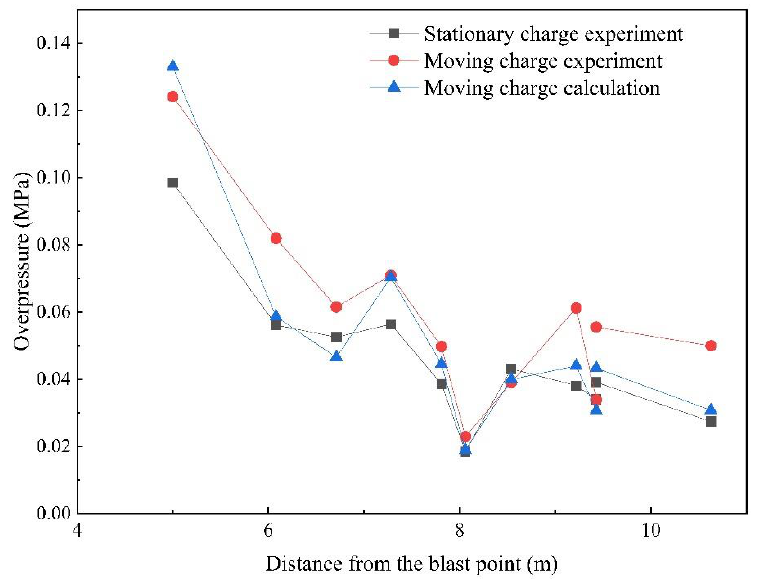
Figure 13. Overpressure values at different distances from the blast center for the stationary charge experiment, moving charge experiment and moving charge calculations.